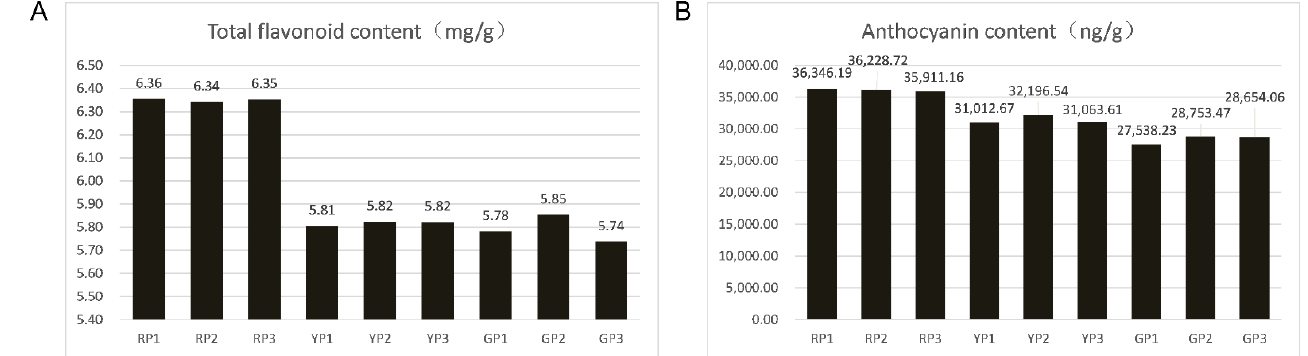
Figure 2. Quantification of bioactive substances: ( A ) total flavonoid content; ( B ) anthocyanin content.